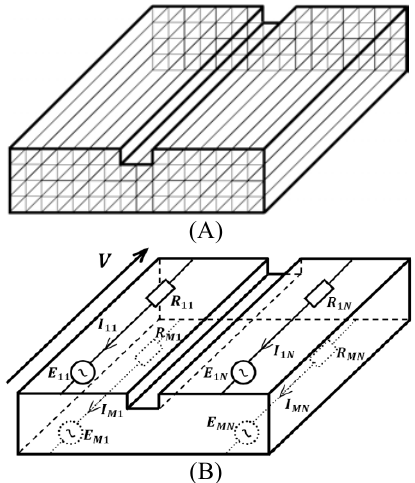
Figure 8: Same view as in figure 5, but there is a calibrated crack in the center of the plate The distribution of the output signal ( 𝐵 of 𝑑 = 1 . 5 𝑚𝑚 from the top surface of the plate is shown in figure 9.